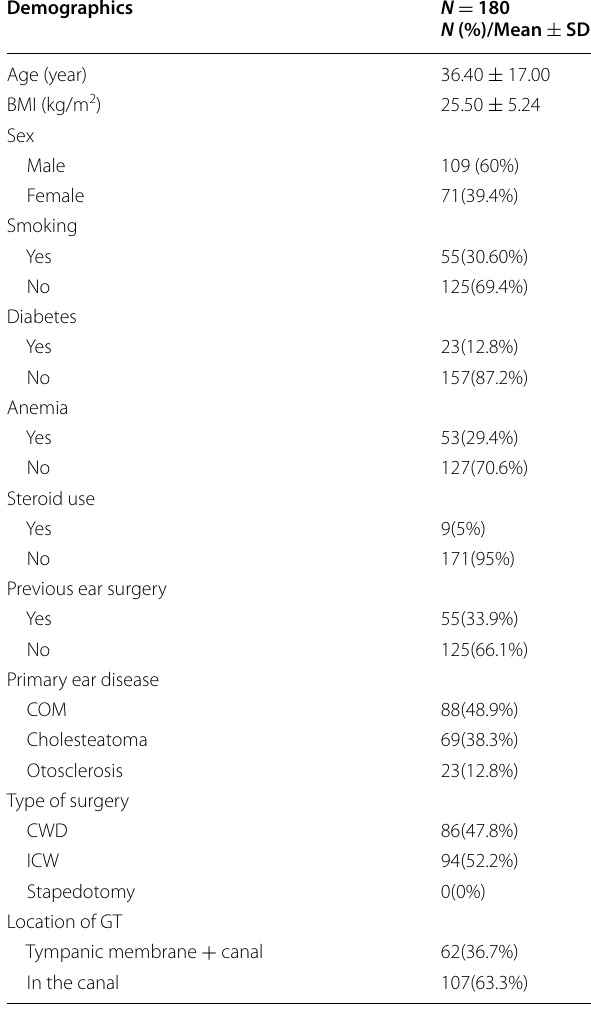
Table 1 Comparison of sex and age variables between cases with and without GT formation